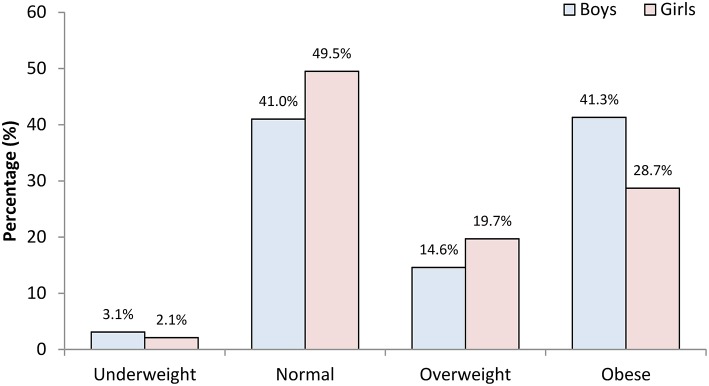
The prevalence of childhood underweight, normal weight, overweight and obesity among Kuwaiti Arab children and adolescent boys and girls aged 6–18 years.